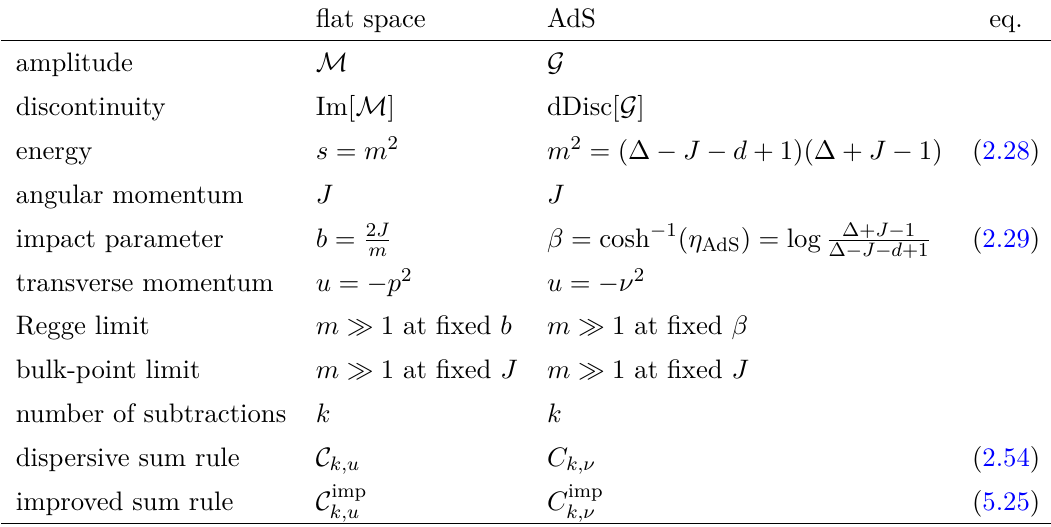
Table 1. A dictionary between relevant notions in flat space and